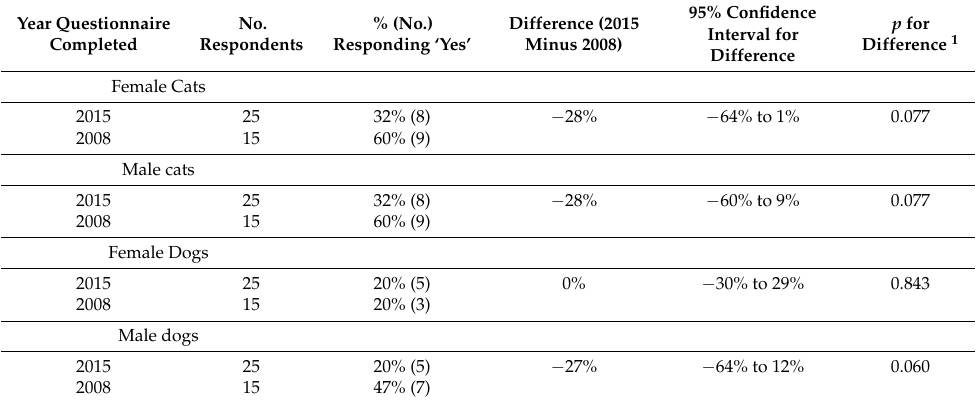
Table 2. Responses of university veterinary teaching staff from Australia and New Zealand in 2008 and 2015 to the question ‘In your personal opinion of early-age desex, do you advocate its use in . . . ’.